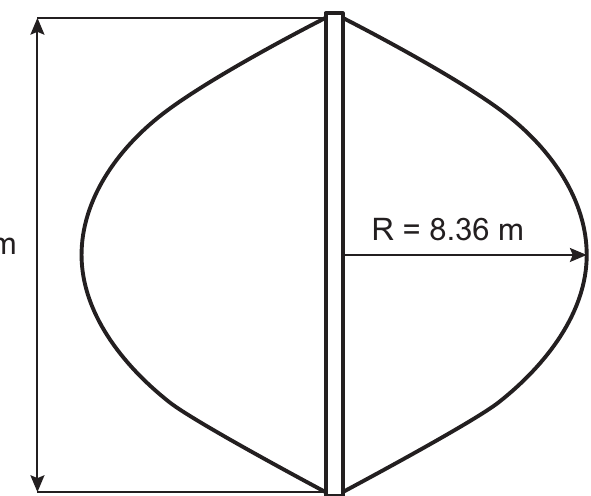
Figure 5. Basic illustration of the Sandia 17-m turbine.